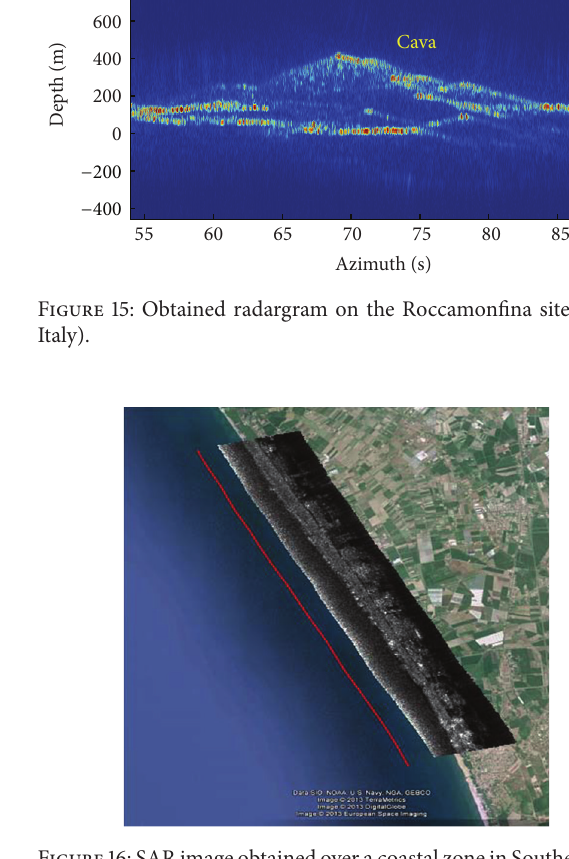
Figure 16: SAR image obtained over a coastal zone in Southern Italy